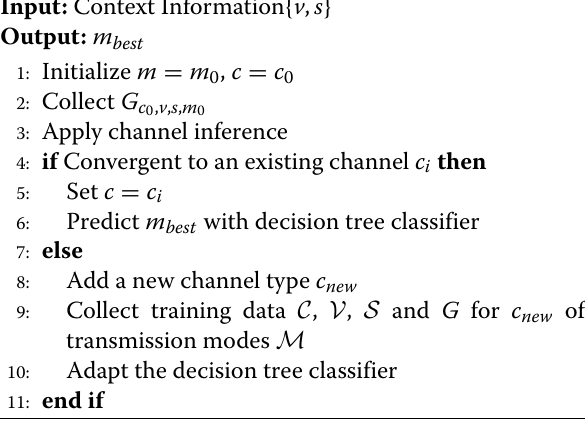
Algorithm 1 Context-Aware Rate